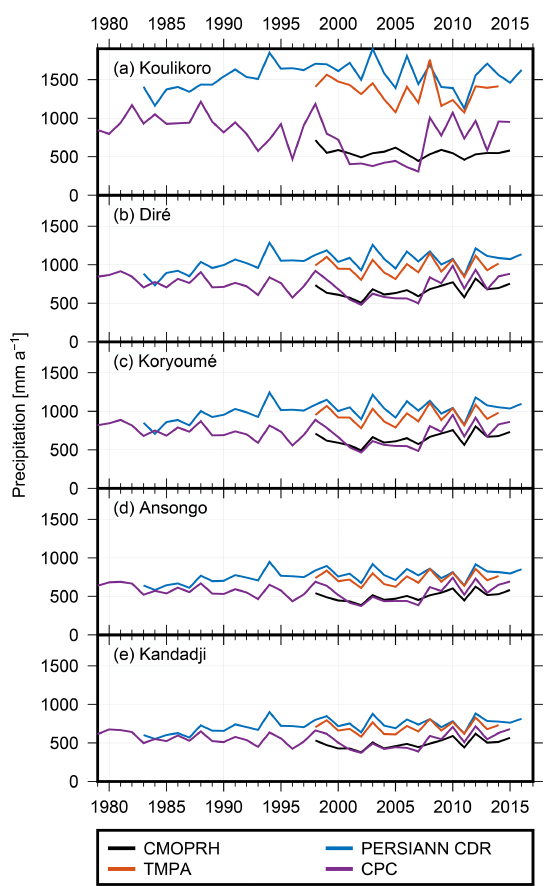
Figure 4. Comparison of precipitation from the data sets PERSIANN-CDR, CMORPH, TMPA, and CPC for the five study